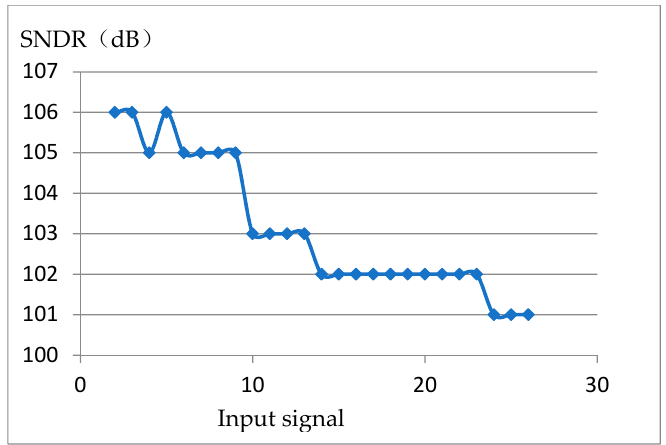
Figure 15. Measured relationship between input signal frequency and signal to noise distortion ratio (SNDR).